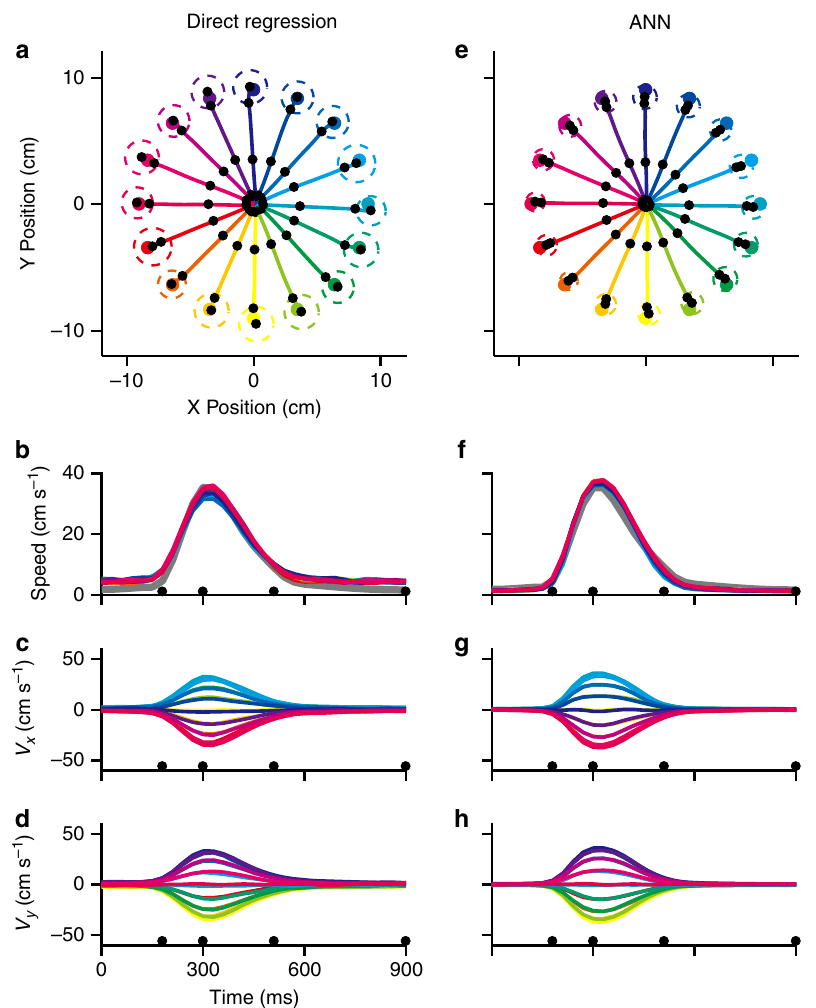
Fig. 6 Population decoding using data simulated with non-uniform distribution of preferred directions and the offset model. a – d Direct Regression decoder. e – h ANN decoder. a , e reconstructed trajectories for the 16 targets. The radii of the dashed circles represent the averaged distance between end-point positions and their mean. b , f reconstructed speed pro fi les. The thick gray line represents the original speed pro fi le. The decoded velocity components, V x and V y , are shown respectively in c , g ; d ,